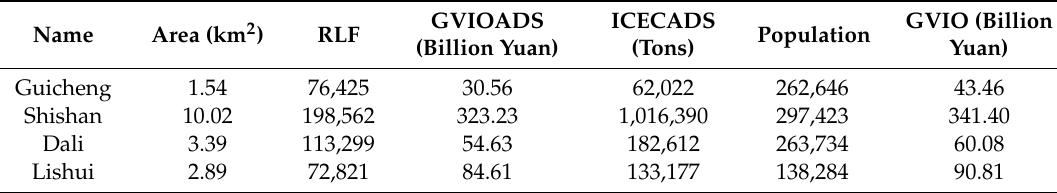
Table 1. Statistical yearbook information for the study